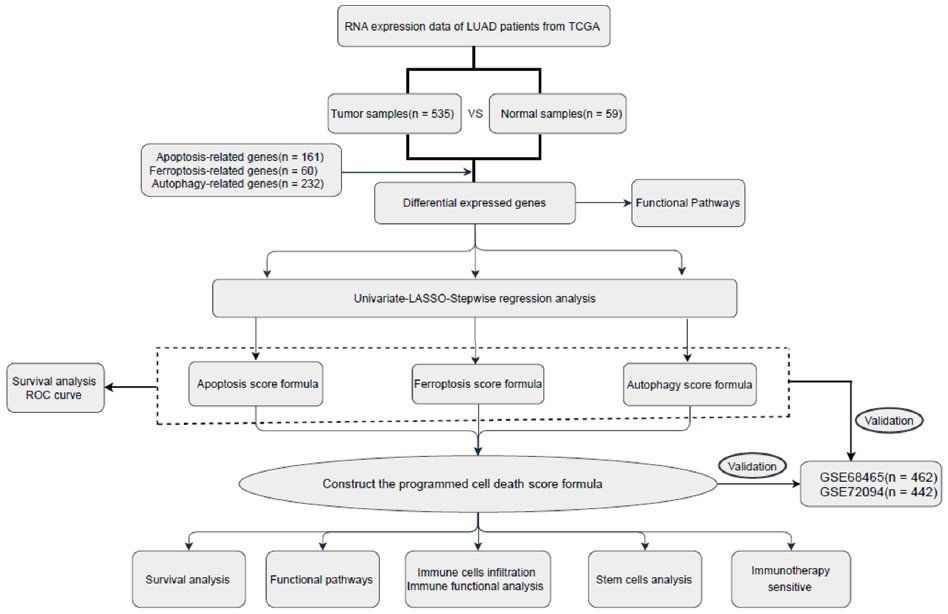
Figure 1. Workflow of this study.